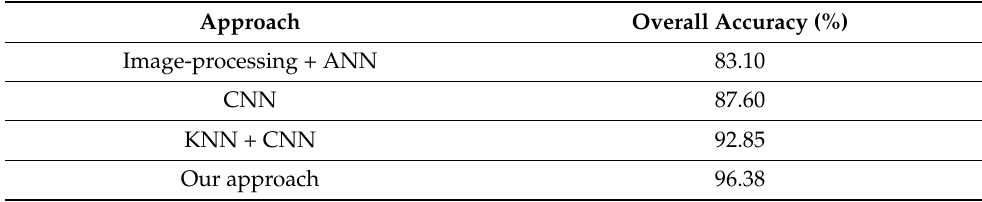
Table 5. Comparison with other